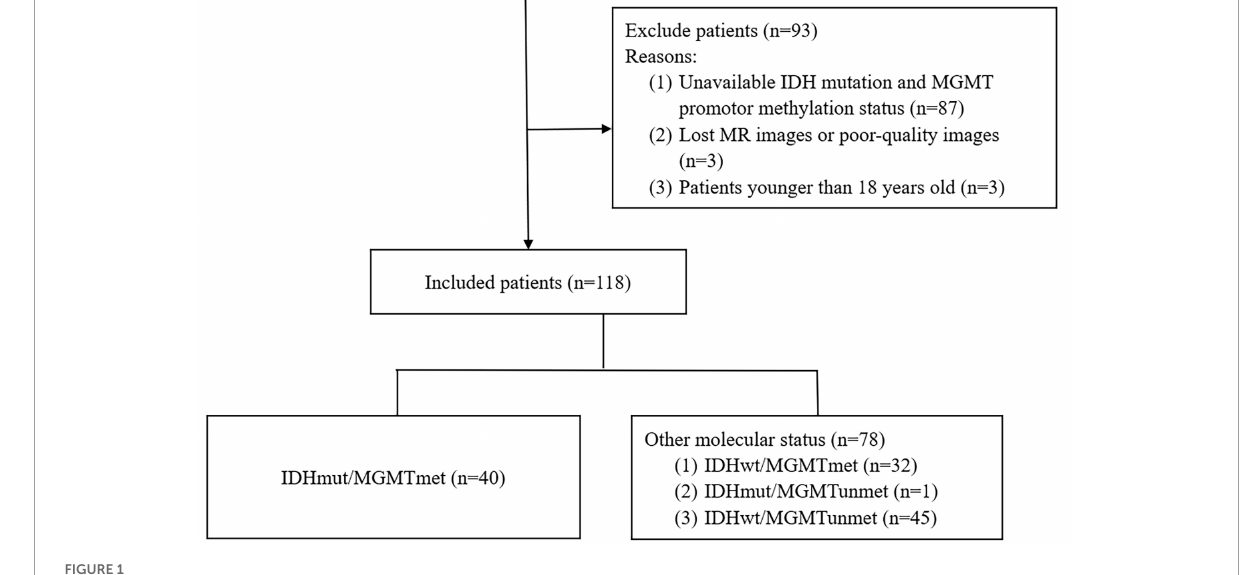
FIGURE1 Flowchart of the collection of patients.